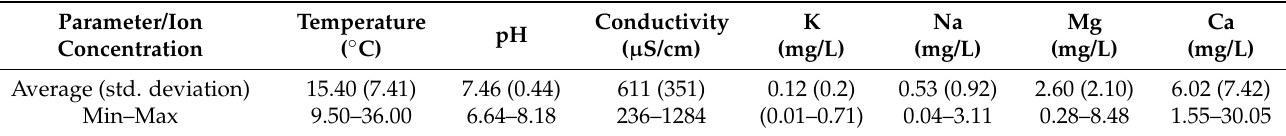
Table 2. Observed background physicochemical properties of the groundwater in the testing area.